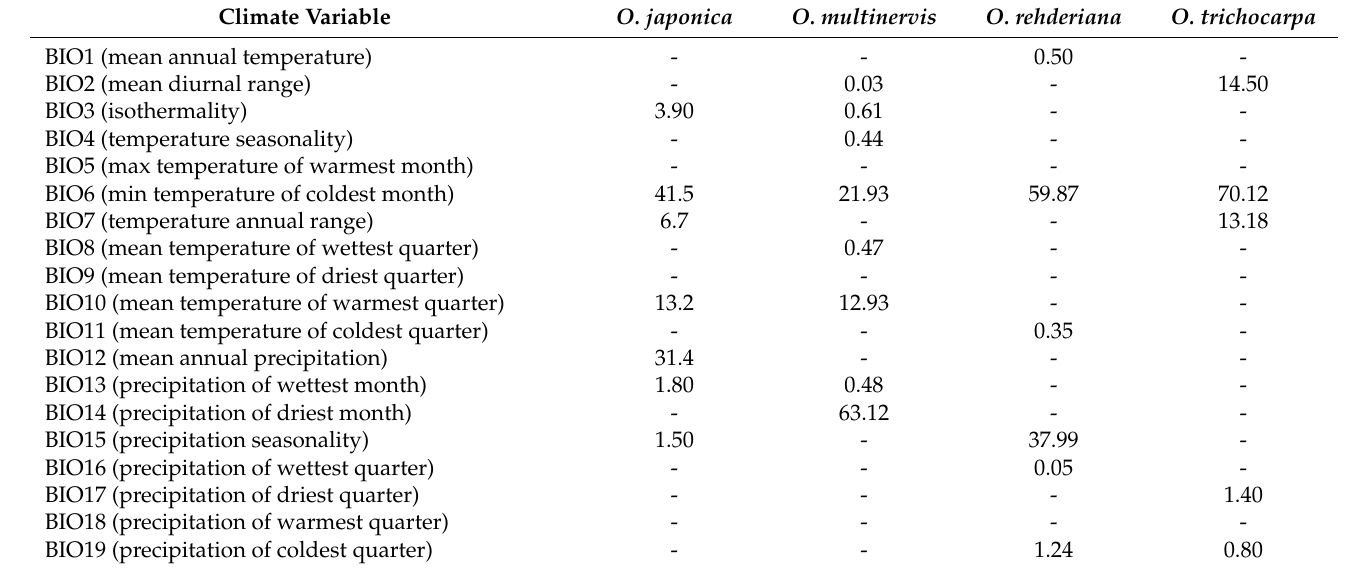
Table 1. Relative contribution proportions (%) of climate variables explaining the current distribution of four Ostrya species. Climate